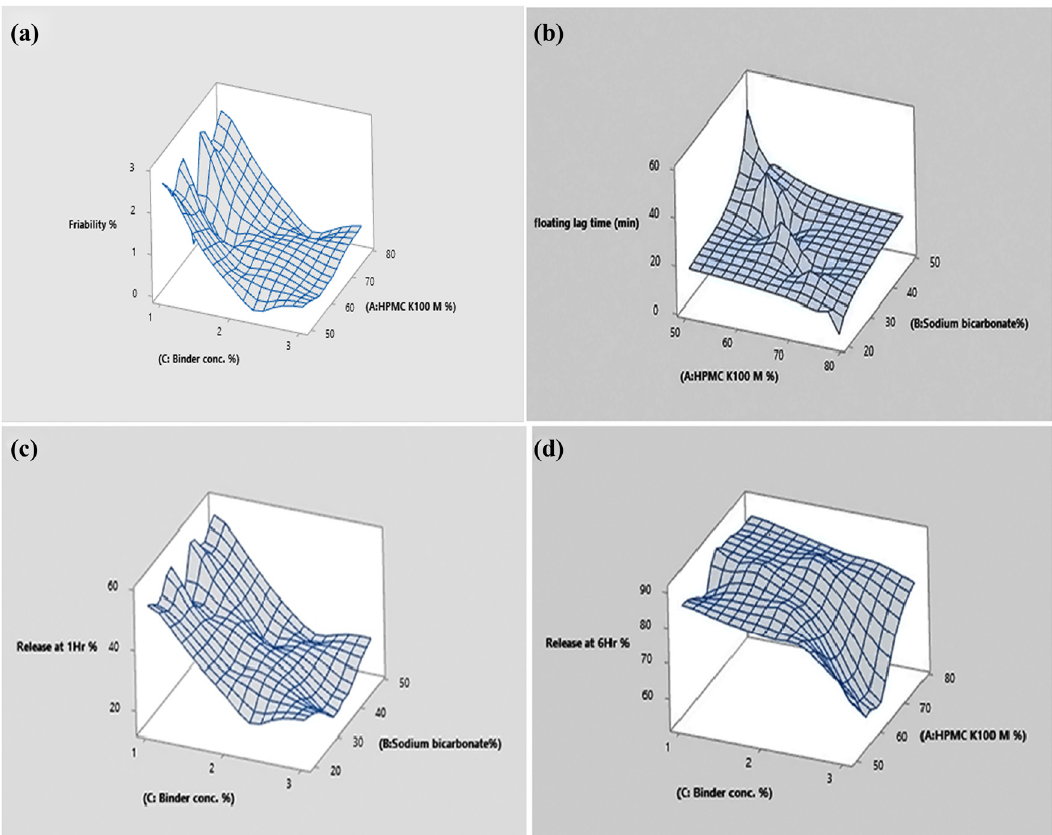
Figure 1: Response surface plots depicting the interaction e ff ects of dependent factors on a Y: friability ( a ) , FLT ( b ) , % release at 1 h ( c ) , and % release at 6 h ( d )